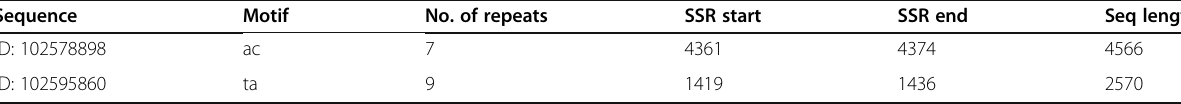
Table 6 Gene sequences with the highest number of dimer repeats Sequence